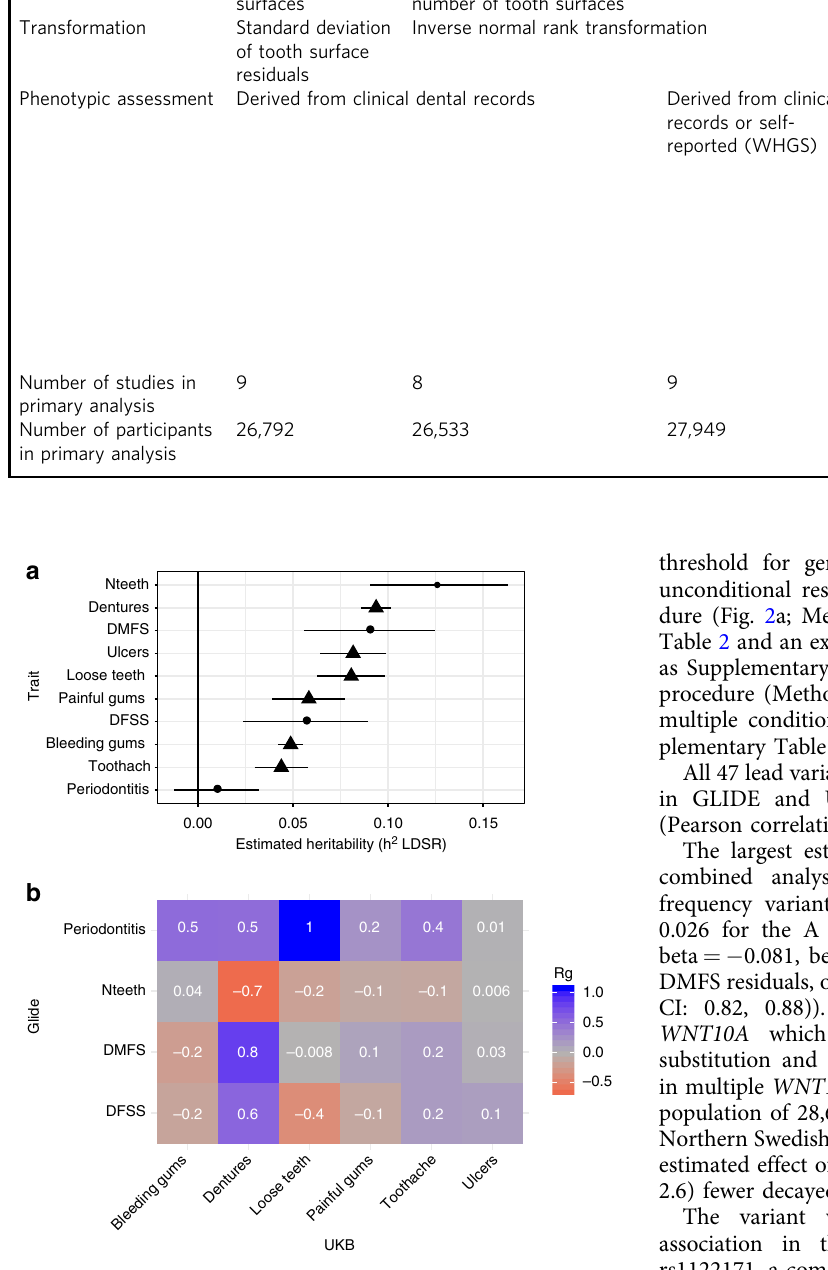
Fig. 1 Estimated heritability of and genetic correlation between measures of dental disease. a estimated heritability (h 2 LDSR ) for each trait in GLIDE (plotted in circles) and UKB (plotted in triangles). Error bars represent 95% con fi dence intervals. b Estimated genetic correlations (R g ) between traits in GLIDE and UKB. Cells are shaded according to the value of R h 2 LDSR = 0.085, LDSR intercept [LDSR i ] = 1.00 for DMFS/ dentures; λ GC = 1.09, h 2 LDSR = 0.046, LDSR i = 1.00 for peri- odontitis/loose teeth).